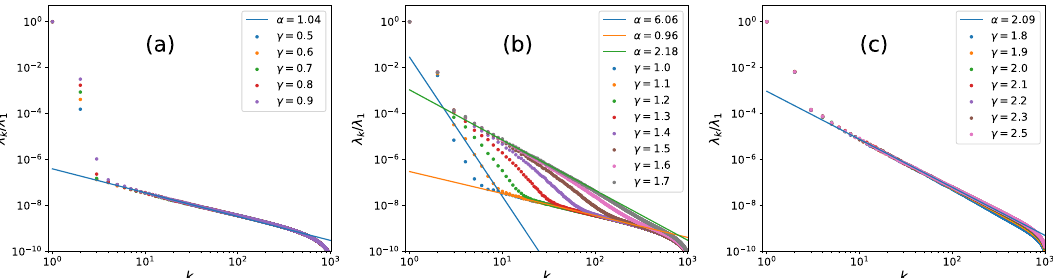
Figure 4. Scree plots of the RP models at various parameters γ , the middle figure ( b ) stands for the NEE regime, identified through the two-branch structure with super-Poissonian behavior (cid:31) k